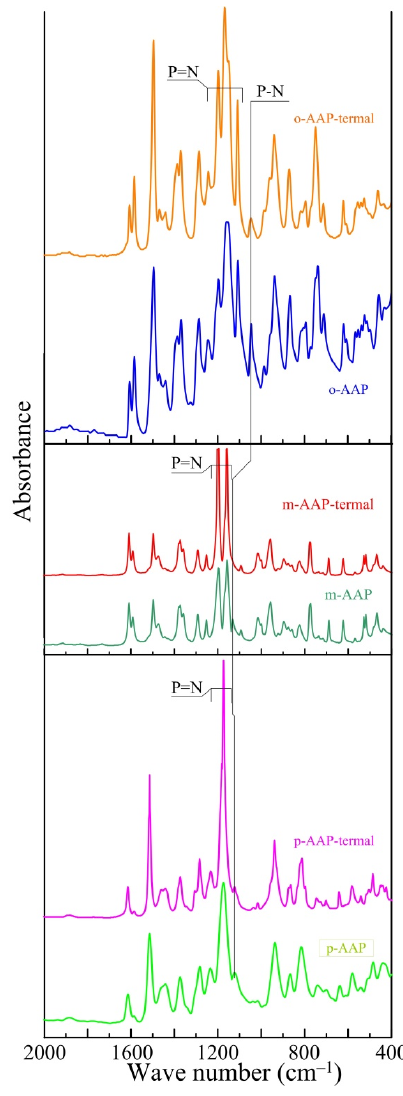
Figure 4. IR spectra preheating and post-heating (termal).